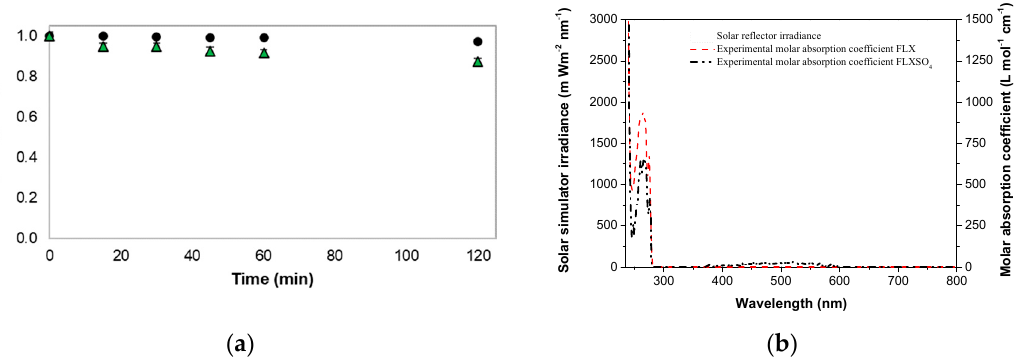
● Figure 2. Direct photolysis of the antidepressants. ( a ) Decay of ( ● ) FLX ( ) FLXSO 4 under simulated Figure 2. Direct photolysis of the antidepressants. ( a ) Decay of ( • ) FLX ( solar radiation; ( b ) Spectral irradiance of the solar simulator (left vertical axis) and spectral decadic molar absorption coefficient of ANT (FLX and FLXSO 4 ) measured in this work (right vertical axis).